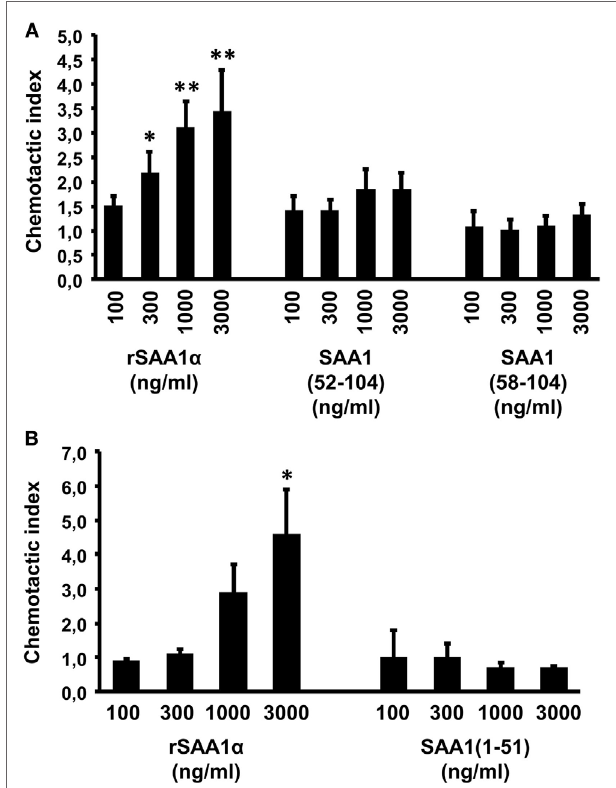
FigUre 5 | The NH 2 - and COOH-terminal serum amyloid A1 (SAA1) peptides are not directly chemotactic for neutrophils. The chemotactic activity of 100–3,000 ng/ml intact SAA1 (a,B) , SAA1(1–51) (B) , SAA1(52–104) (a) , and SAA1(58–104) (a) was evaluated on human neutrophils in the Boyden microchamber assay. The chemotactic potencies are expressed as mean chemotactic index ± SEM from four (B) to six (a) independent experiments. Statistically significant differences compared with controls, determined by the Mann–Whitney U test, are indicated by asterisks (* p < 0.05 and ** p <